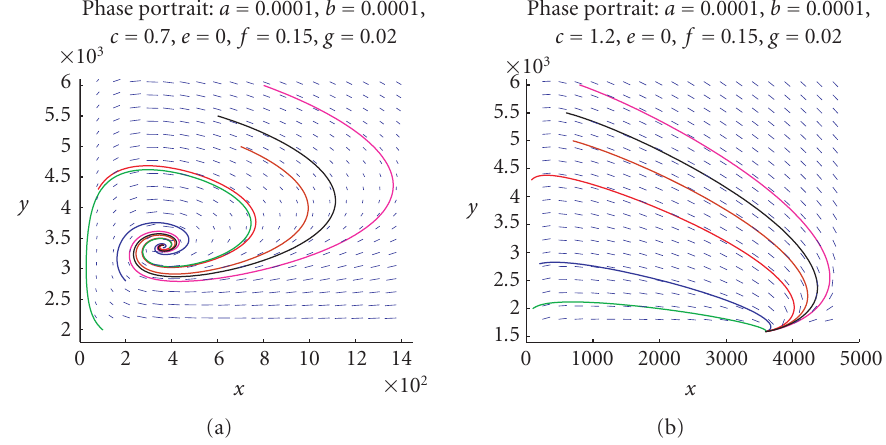
Figure 3.13. The e ff ect of the parameter c in its influence on the steady state values and the dynamical behavior of the system. (a) c = 0 . 7. The fixed point is at x 0 ≈ 361, y 0 ≈ 3361. (b) c = 1 . 2. The fixed point is at x 0 ≈ 3588, y 0 ≈